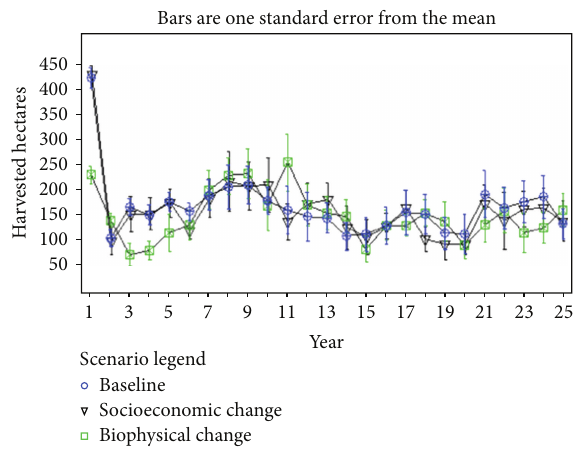
Figure 4: Interval plot of total harvested hectares by scenario and year. A 95% confidence interval plot for the mean of the 10 runs within each scenario of total harvested (combined light and heavy) hectares by year. Here the shapes represent the mean, and the perpendicular lines the interval of one standard